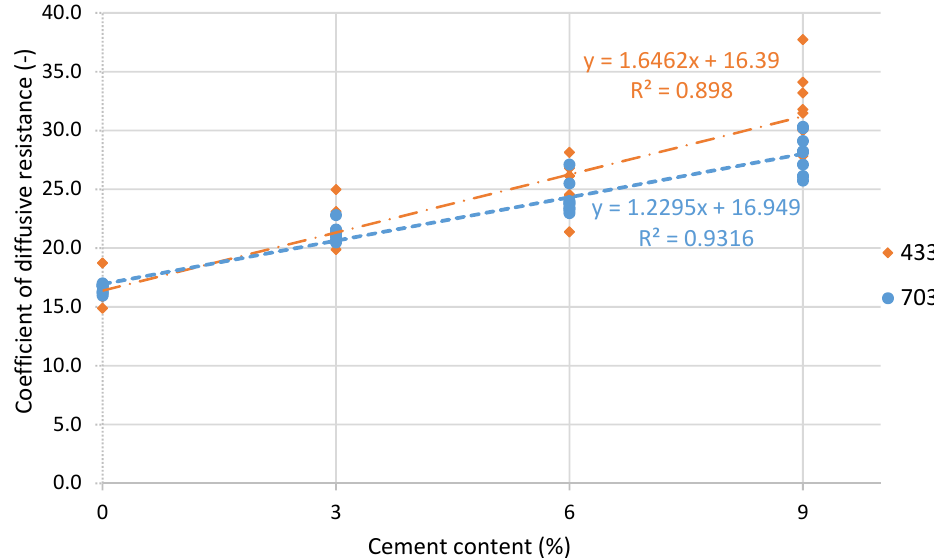
Figure 9. Effect of cement addition of CSRE coefficient of diffusive resistance (linear regression).